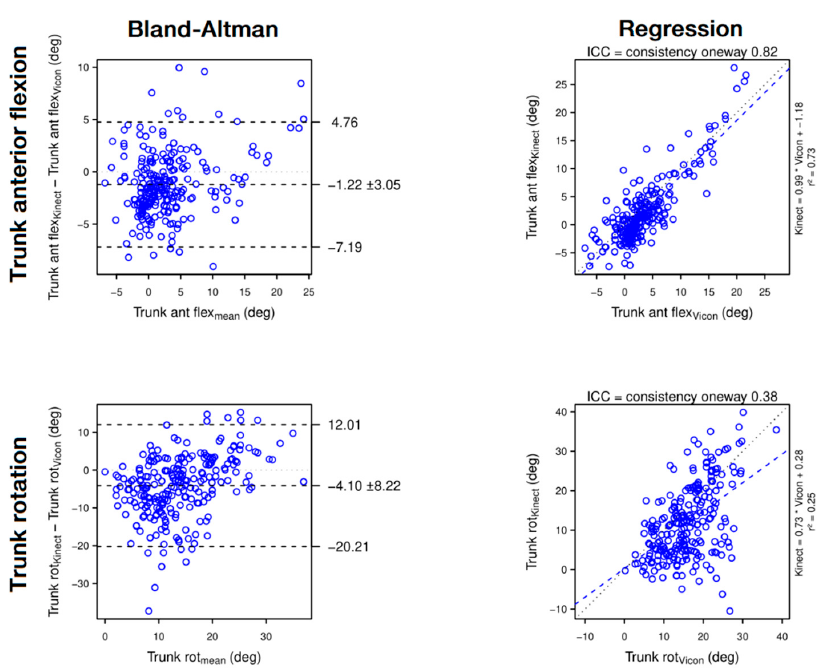
Figure 4. Bland–Altman plots ( left panels ) and regression plots ( right panels ) of trunk anterior flexion (1st row) and trunk rotation (2nd row). The Bland–Altman plots show that the Kinect moderately underestimates trunk anterior flexion and trunk rotation. The regression plots show that, when assessed with the Kinect, trunk anterior flexion is reliable, but trunk rotation is poorly reliable.